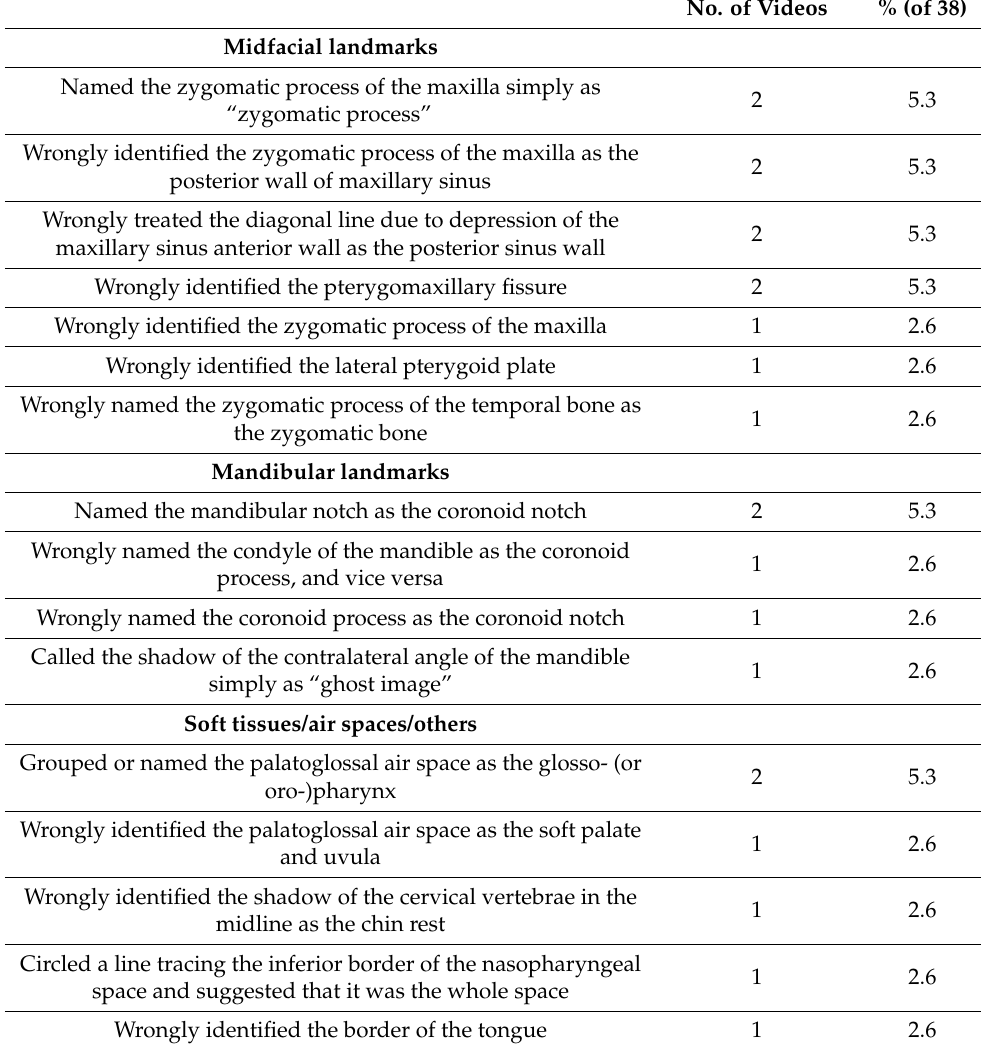
Table 3. Details of inaccurate descriptions of the anatomical landmarks.